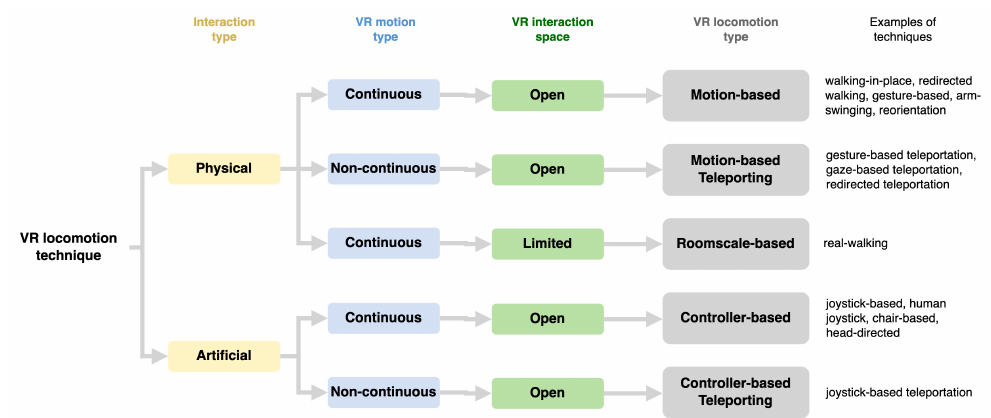
Figure 4. The updated typology of VR locomotion